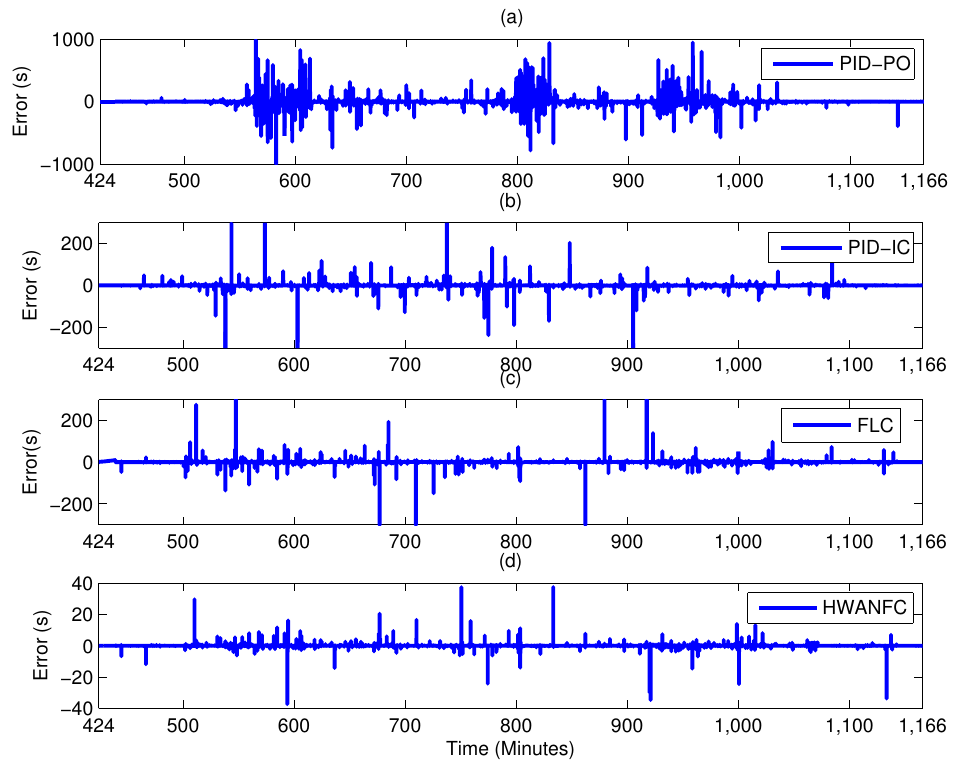
Figure 5. Maximum Power Point Tracking Error (MPPT) error of the PV system using various controllers ( a ) PID based P&O; ( b ) PID based IC; ( c ) FLC; ( d ) proposed